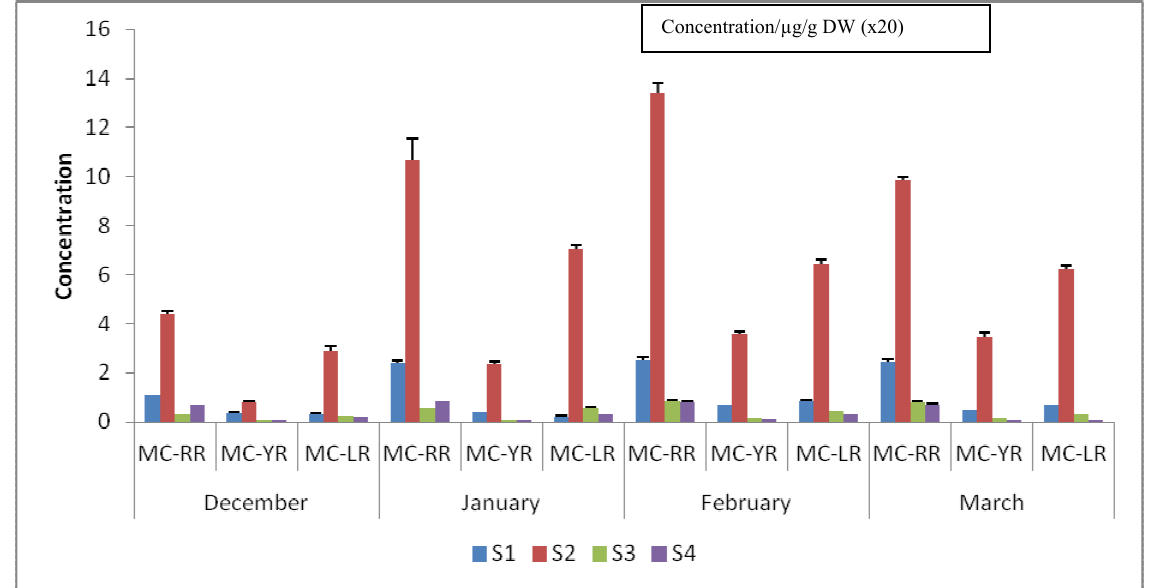
Figure 2. Graphical presentation of the quantitative variations of MC-RR, -LR and -YR among sites (S1 to S4) and months